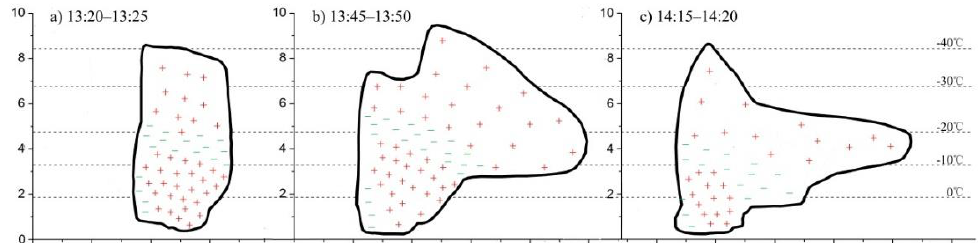
Figure 8. Schematic diagram of the charge structure evolution of the thunderstorm cell. ( a ) 13:20- 13.25, representing the mature stage of the storm cell; ( b ) 13:45-13:50, representing the stage when hail began to grow; ( c ) 14:15-14:20, the stage after the hail.